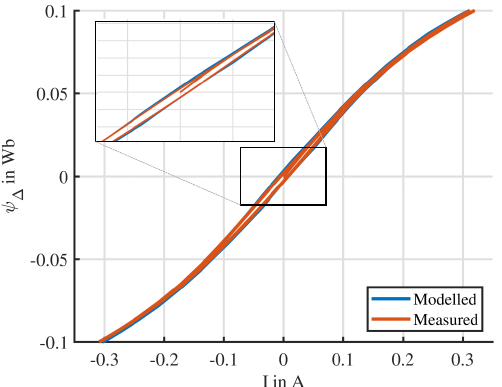
Figure 14. Experimentally-measured incremental flux compared to the identified MPI model.